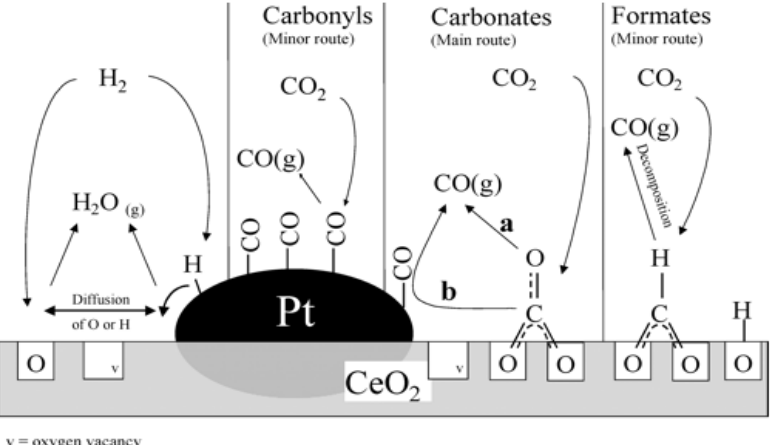
Figure 22. The proposed rWGS reaction mechanism over Pt/CeO 2 . Reproduced with permission from Ref. [195]. Copyright© 2004, American Chemical Society.